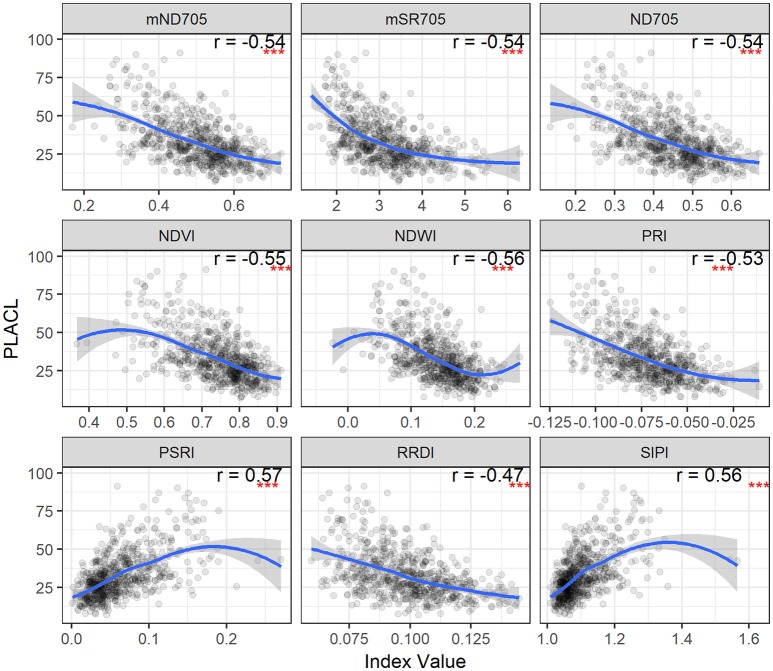
STB percentage of leaf area covered by lesions (PLACL) plotted as a function of spectral indices for the second collection. Correlation coefficients (r) are for the Spearman's correlations between the spectral indices and PLACL (***p < 0.001). Loess fit lines are added to the scatter plot to show the trend of the relationship. Results are based on the data of the whole population (335 varieties) used in the main experiment.